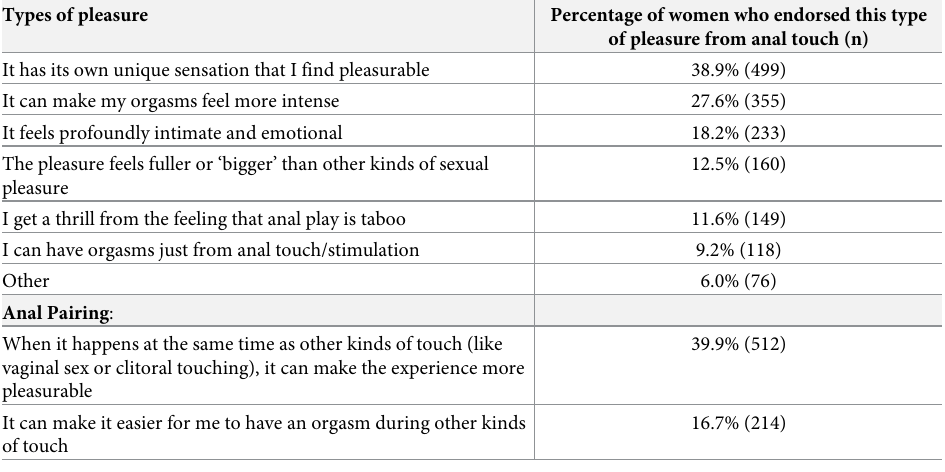
Table 5. Ways in which anal touch is pleasurable reported by women endorsing pleasure from any form of anal touch (N = 1283, weighted). Types of